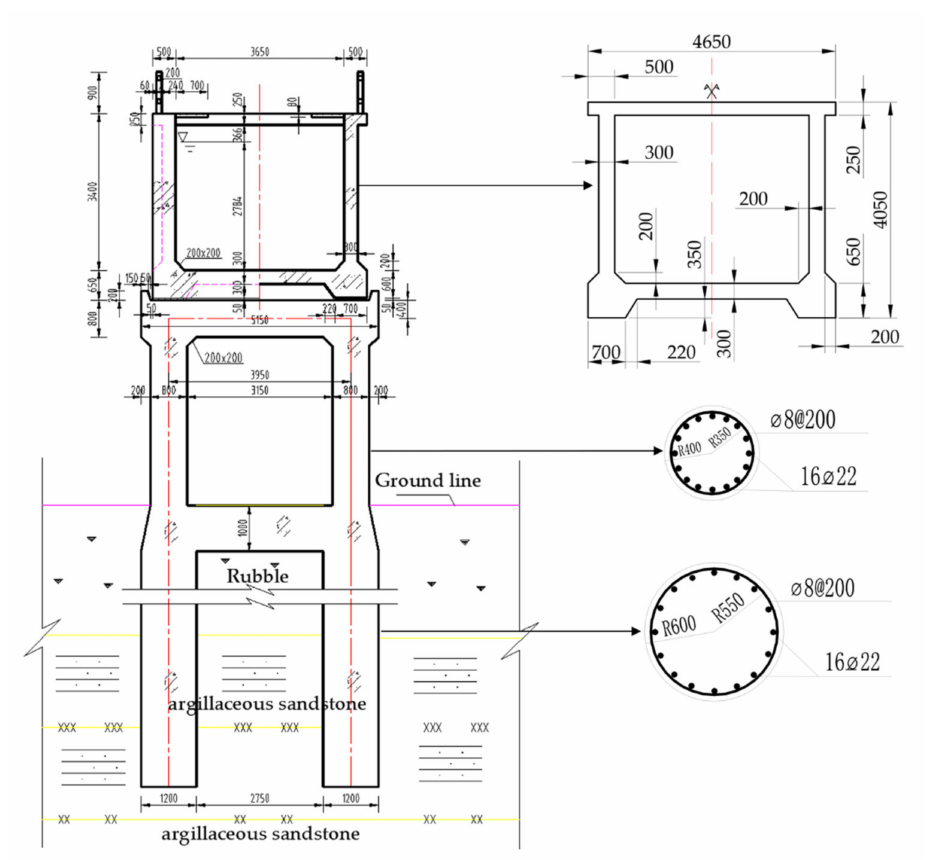
Figure 2. Schematic diagram of the aqueduct in the transverse direction (unit: